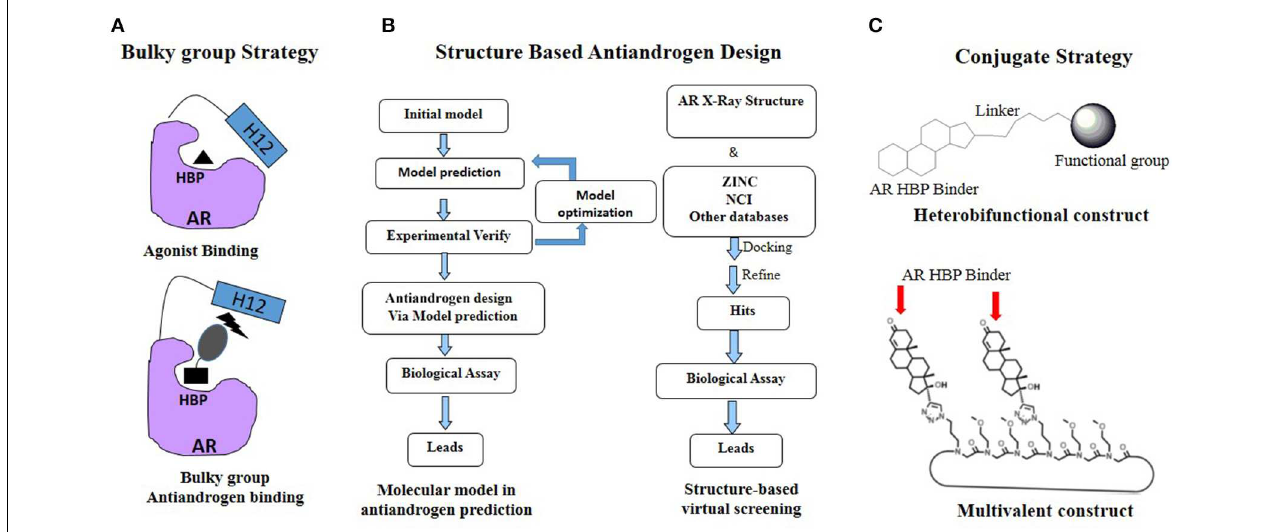
FIGURE 3 | Rational antiandrogen design strategy to combat the mutation driven drug resistance. (A) Bulky group strategy. (B) Structure based antiandrogen design. (C) Conjugate strategy.